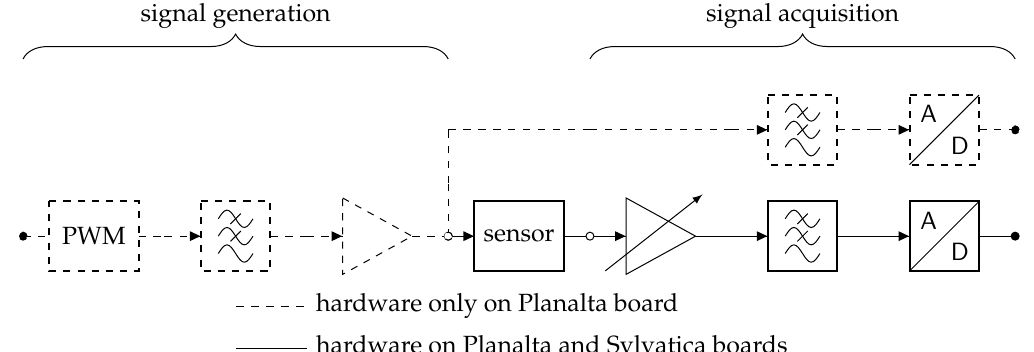
Figure 2. Block diagram of the analogue front-end for Sylvatica and Planalta boards. The Planalta-only driver generates a voltage wave that is generated through a pulse-width modulation (PWM) signal, which is low-pass filtered and then buffered before being fed into the sensor. The sensor output on both the Planalta and Sylvatica boards is (optionally) amplified using a Programmable Gain Amplifier (PGA) and low-pass filtered before being